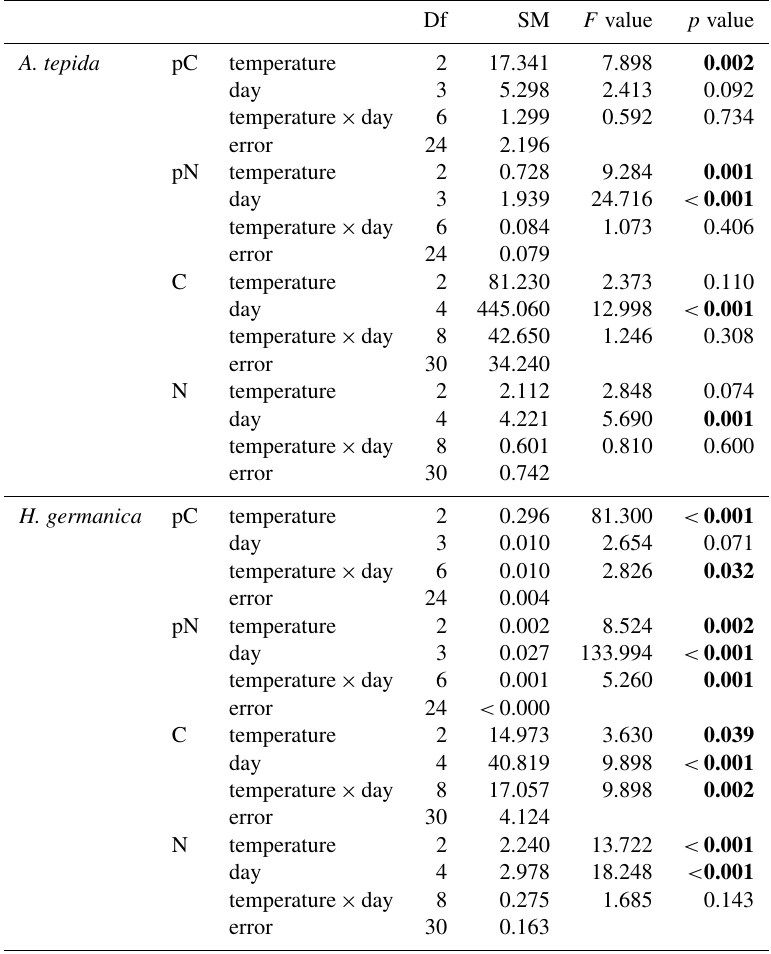
Table 2. Effects of time and temperature. Results of a two-way ANOVA displaying the main effects of time and temperature on the dependent variables pC, pN, C, N in A.tepida and H. germanica and their interactions. Significant p values are printed in bold letters. Df